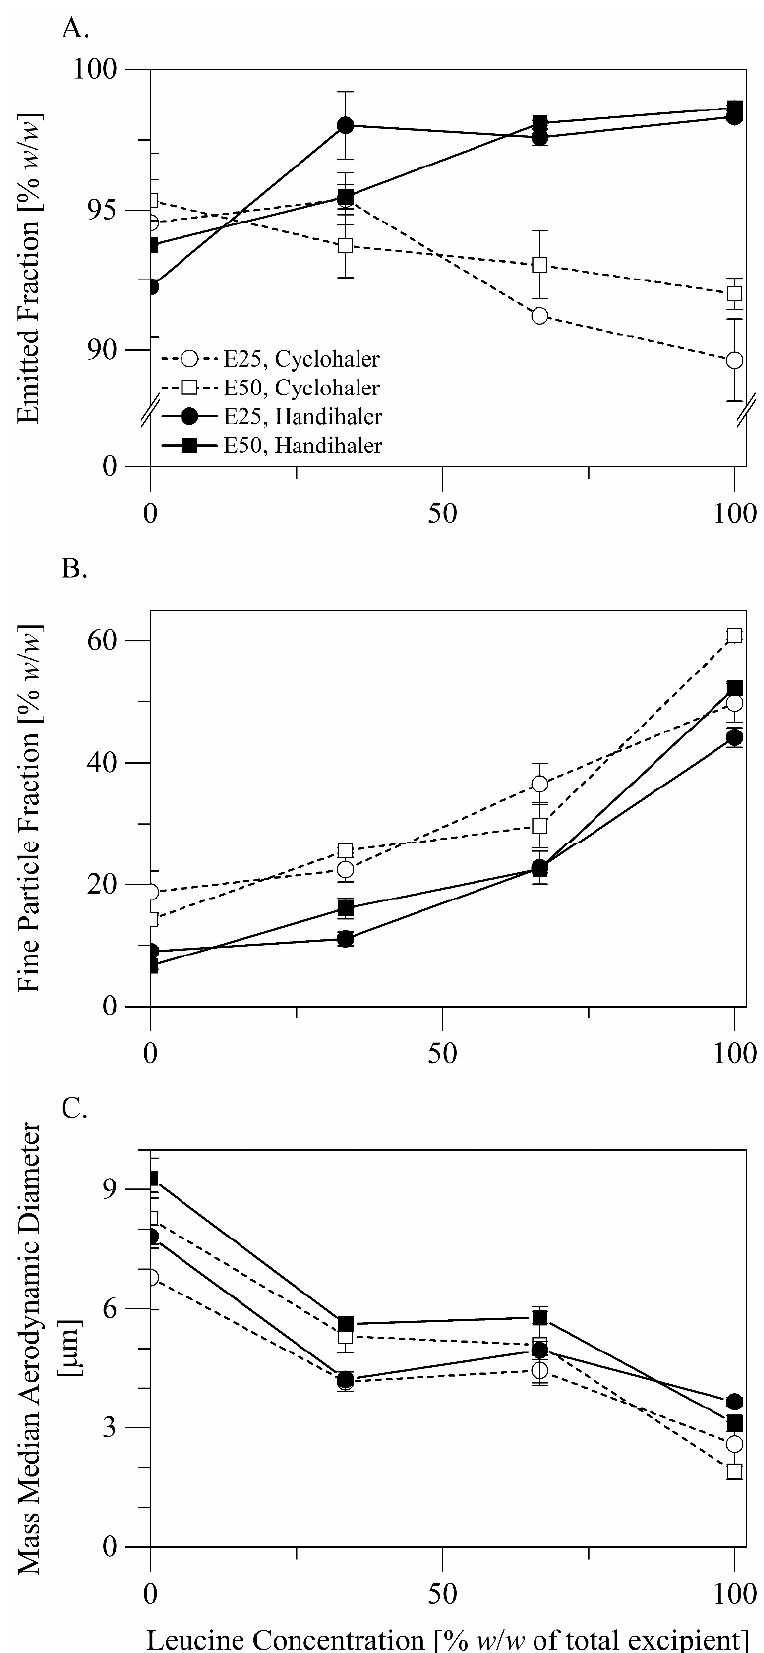
Figure 5. In vitro aerodynamic performance of the formulations: ( A ) the emitted fraction, ( B ) the fine particle fraction, ( C ) the mass median aerodynamic diameter.